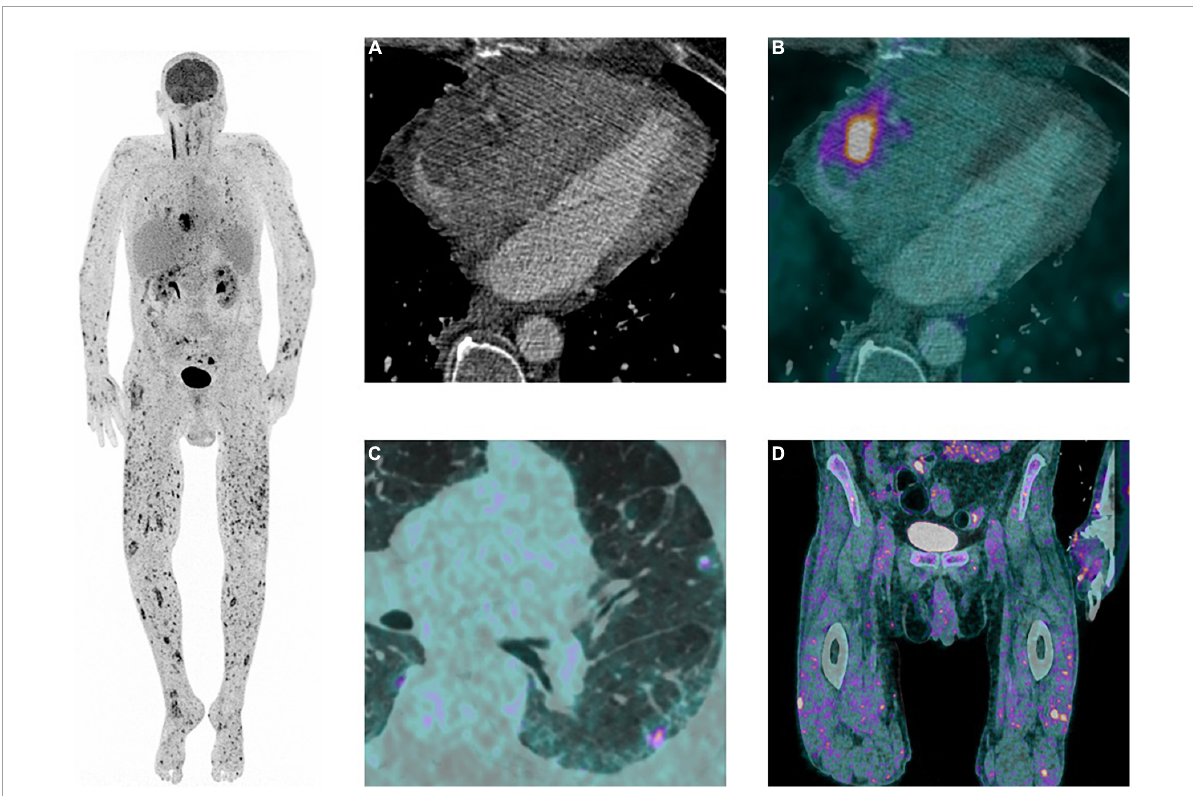
FIGURE3 18 F-fluodeoxyglucose ([ 18 F]FDG) Positron emission tomography (PET)/computed tomography angiography (CTA) findings. Left: Maximum intensity projection image of the whole body showing pathological focal diffuse [ 18 F]FDG uptake of the trunk as well as the upper and lower extremities. Right: (A) Cardiac CTA showing an heterogeneous mass with irregular margins, in contact with the lateral wall of the right atrium with extension in the pericardial space. (B) Transaxial view of [ 18 F]FDG PET/CTA showing pathological [ 18 F]FDG accumulation of the right atrial mass, suggestive of an active infectious process. (C) Transaxial view of [ 18 F]FDG PET/CTA showing focal subpleural nodules with increase [ 18 F]FDG accumulation in the left lung, suggestive of septic emboli. (D) Coronal view of [ 18 F]FDG PET/CT showing focal increased cutaneous and subcutaneous [ 18 F]FDG accumulation in the proximal part of the lower limbs, suggestive of septic